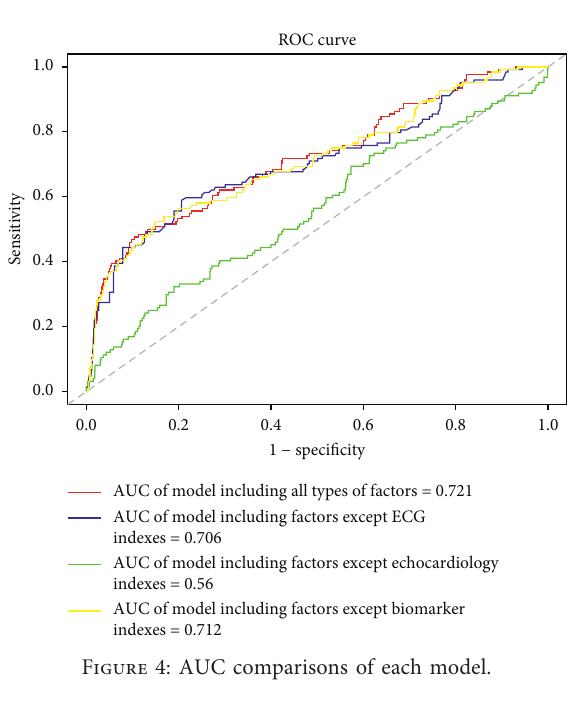
Figure 4: AUC comparisons of each